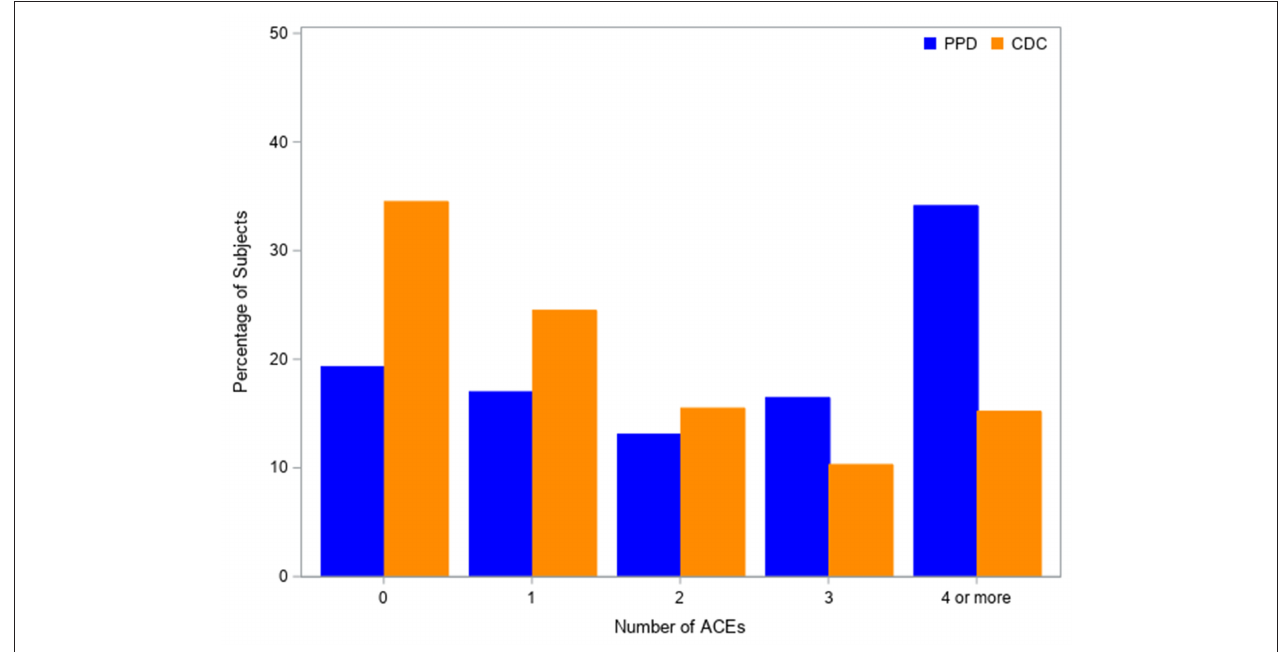
FIGURE 1 | Kaiser-ACE study female population vs. postpartum depression